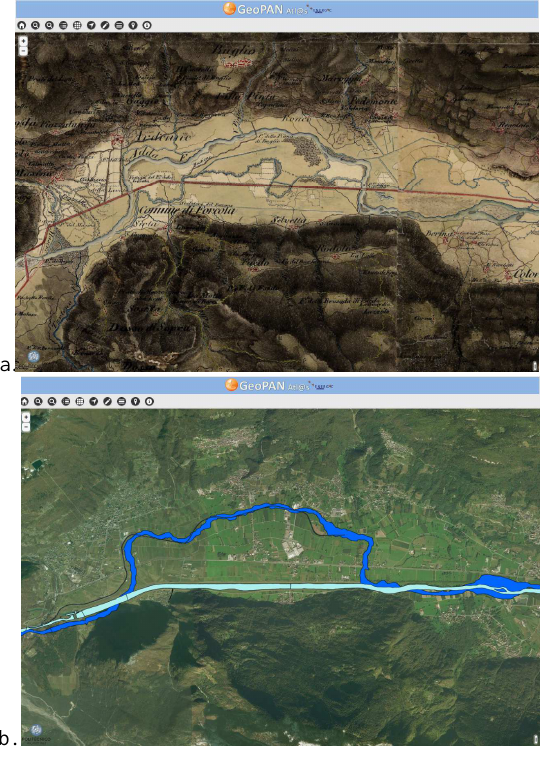
Figure 5. Adda river in the area Pian della Selvetta in XIX century (a) and currently (b) with overlaid current riverbed (light blue) and former riverbed (dark